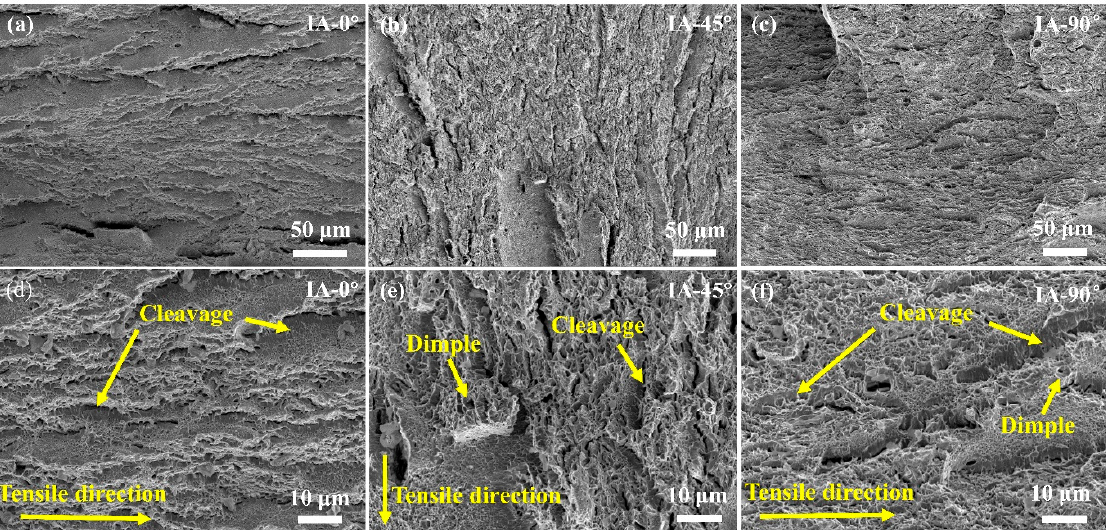
Figure 6. Fracture morphology of IA steel after the uniaxial tensile test along the ( a , d ) 0°, ( b , e ) 45°, and ( c,f ) 90° directions with respect to the rolling direction; ( d – f ) is a magnified view of ( a–c ).